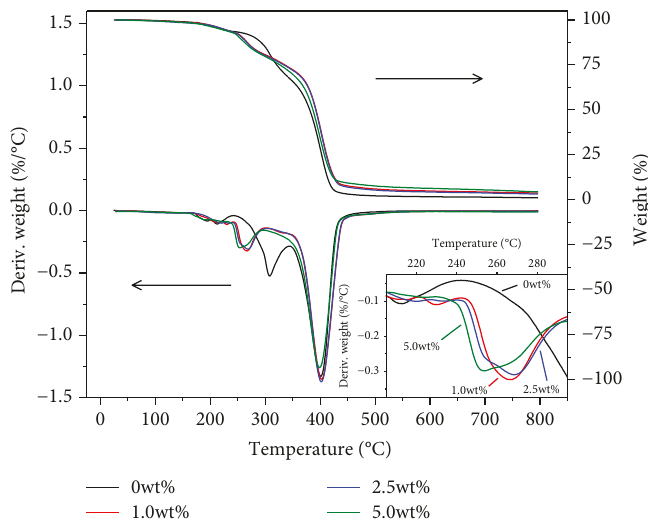
Figure 2: TG and DTG curves of LPCA-WPU elastomers with di ff erent loadings of LPCAs. Table 3: Weight percentage of the residue ( w ), temperature of the r ) and the hard segments weight loss peak of the soft segments ( t SS ( t ) of LPCA-WPU elastomers with di ff erent loadings of LPCAs. HS LPCA loading w r